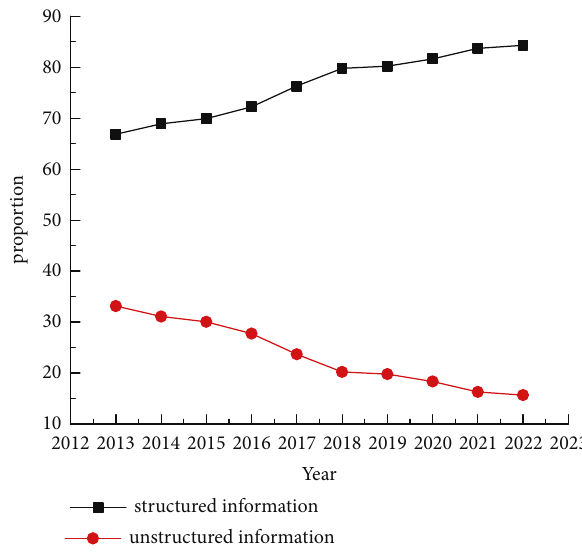
Figure 5: The proportion of structured and unstructured building information to green building